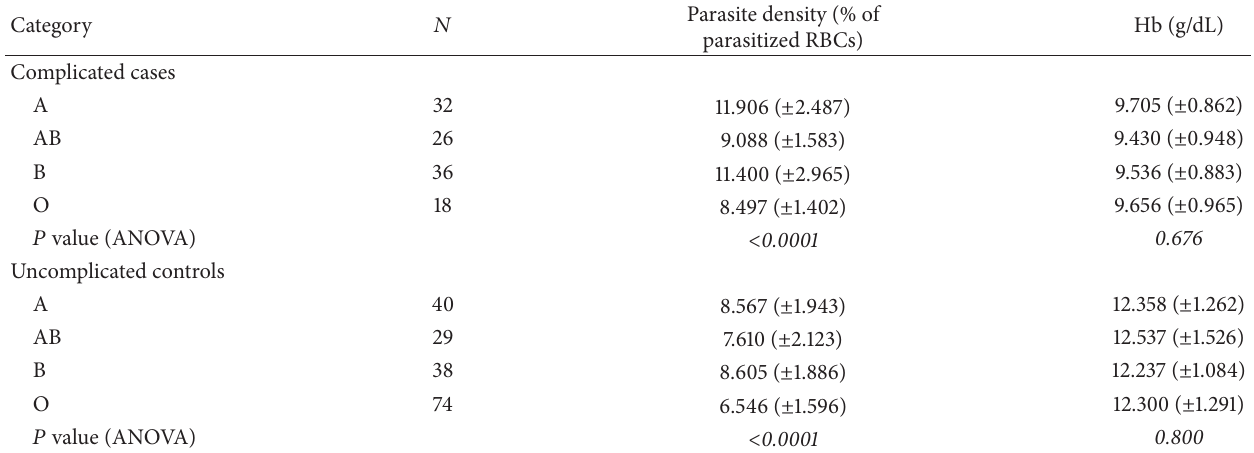
Table 2: Blood group distribution in complicated cases and uncomplicated controls.